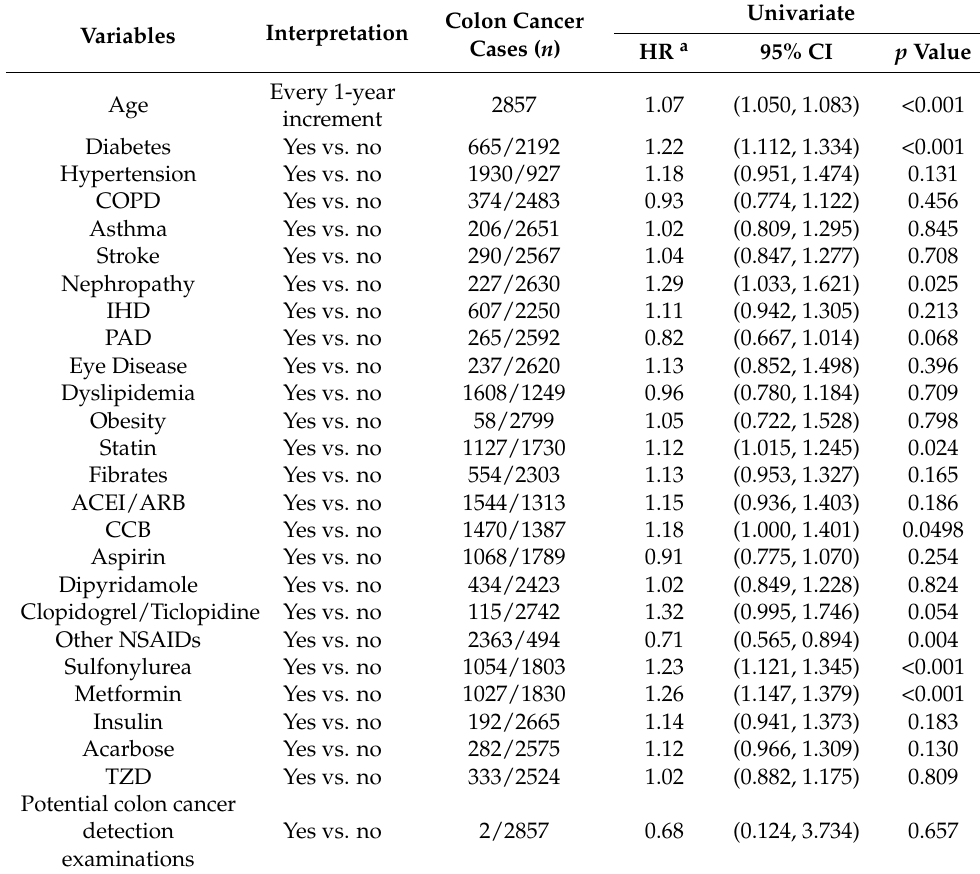
Table 2. Risk factors associated with colon cancer incidence for women aged 40 to 64